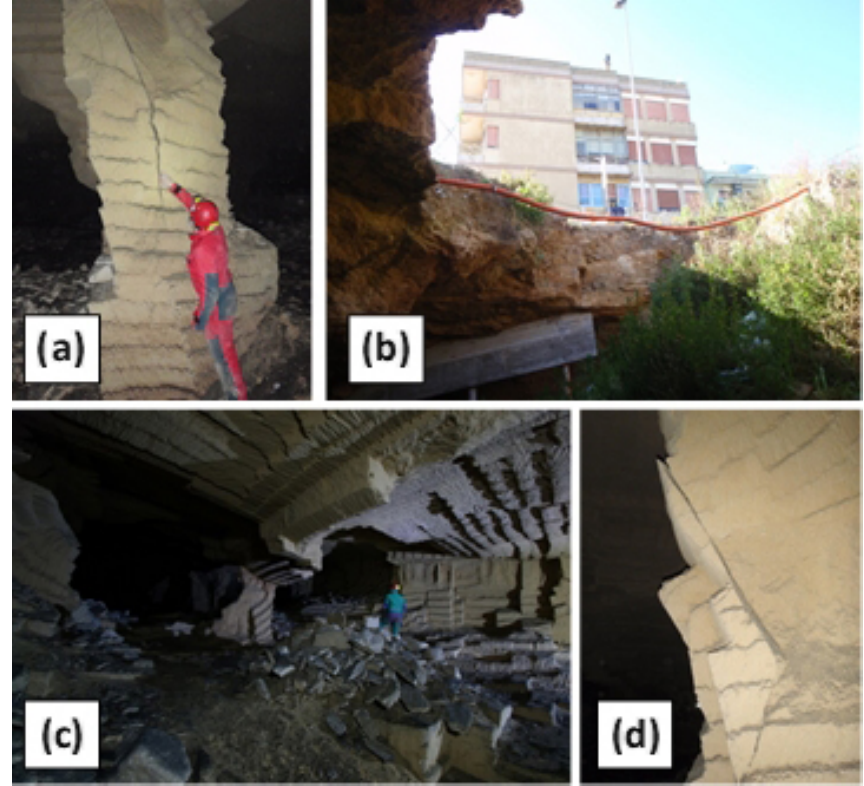
Figure 14. Evidence of instability at the Gallipoli underground quarry: (a) extensive fracturing in a pillar; (b) view of sinkhole from the bottom; (c) inner view of one of the longest rooms in the cavity (block detachments from the vault and debris heaps on the floor); (d) incipient block detachment from a